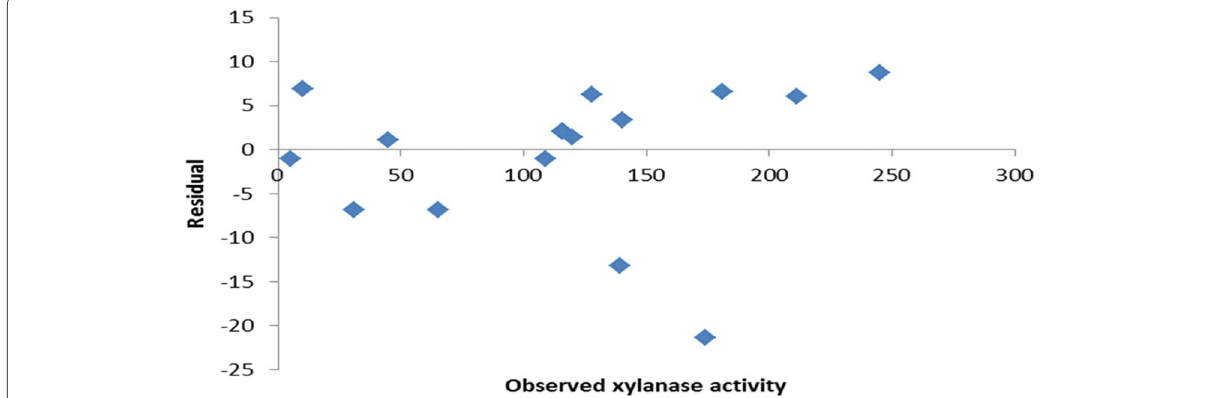
Fig. 5 Residual plot of the observed‑predicted values (residuals) versus the response (optimization process) of A. terreus